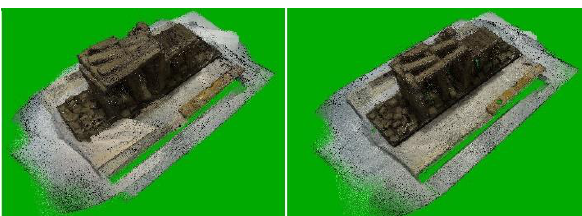
Figure 9. Photogrammetric TIN Figure 10. Point cloud after processing of the algorithm: online registration (left), HQ registration